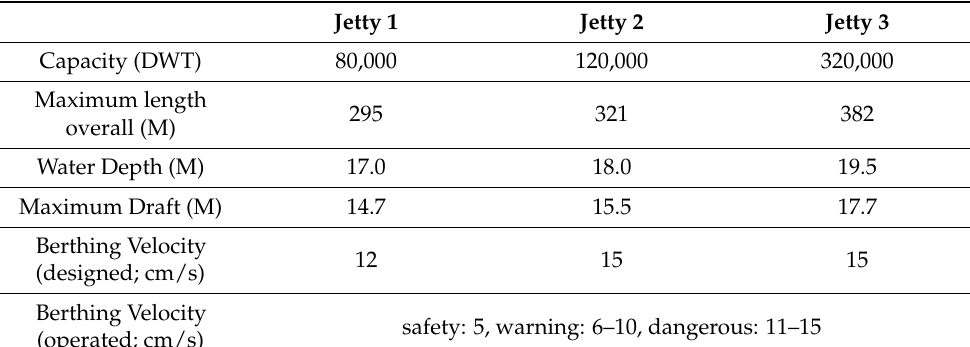
Figure 5. Location and view of the target terminal. Table 1. Terminal specifications .